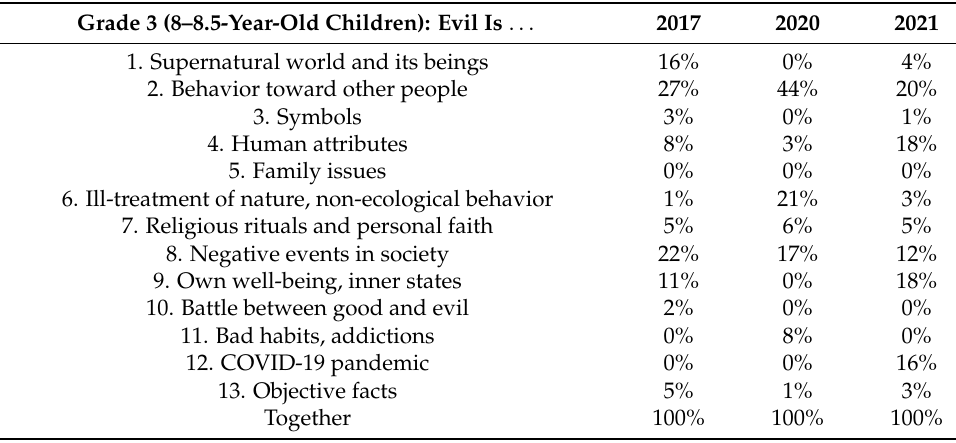
Table 7. The concept of evil by 8–8.5-year-old children (Grade 3). Grade 3 (8–8.5-Year-Old Children): Evil Is . .